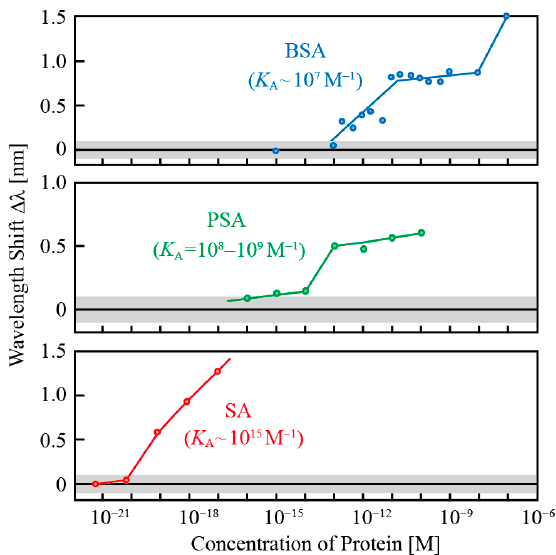
Table 1. Performance comparison of label-free photonic biosensors in references and the electronics biosensor. SPR: surface plasmon resonance; LSPR: localized surface plasmon resonance; PC: photonic crystal; NS: nanoslot; CNT: carbon nanotube; SiNW: Si nanowire; IgG: immuno-globulin G; IL-2: